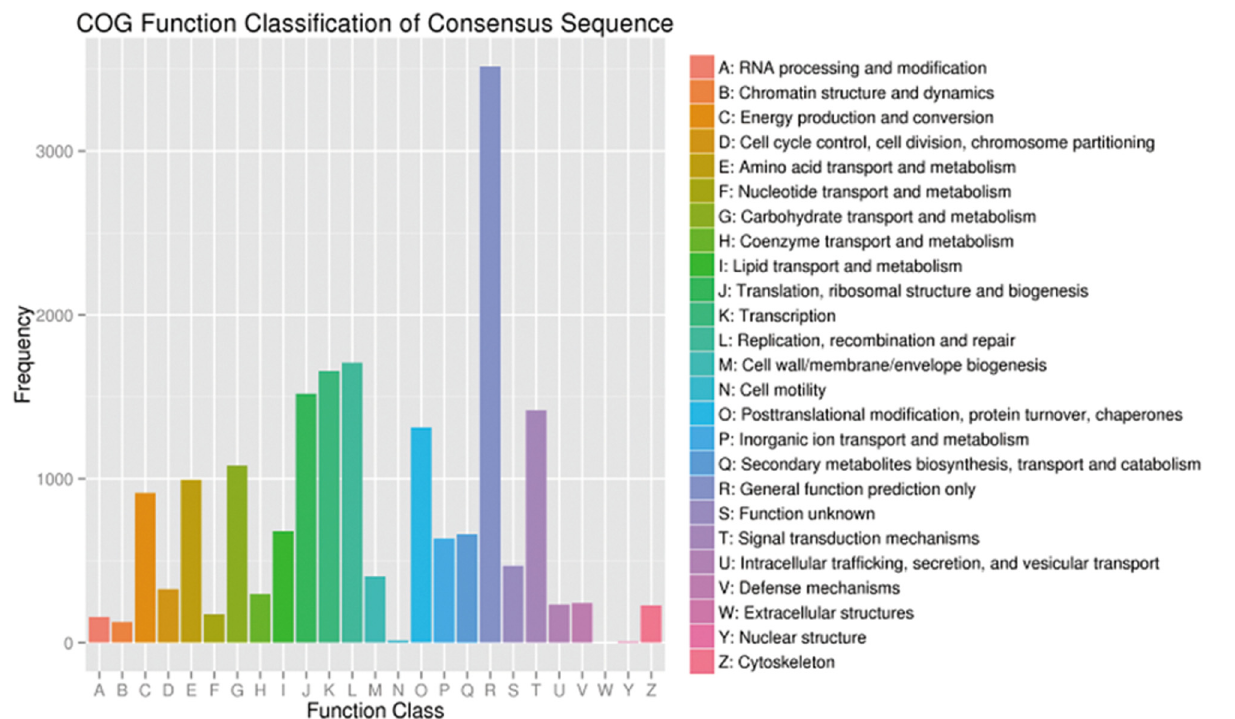
Fig 5. GO categories of the Artemisia sphaerocephala unigenes.